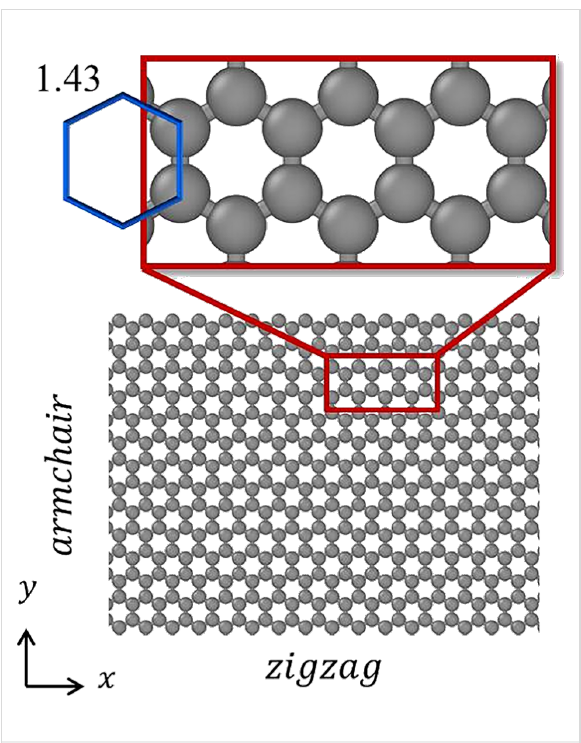
Figure 2: Two different graphene chiralities and the bond length of